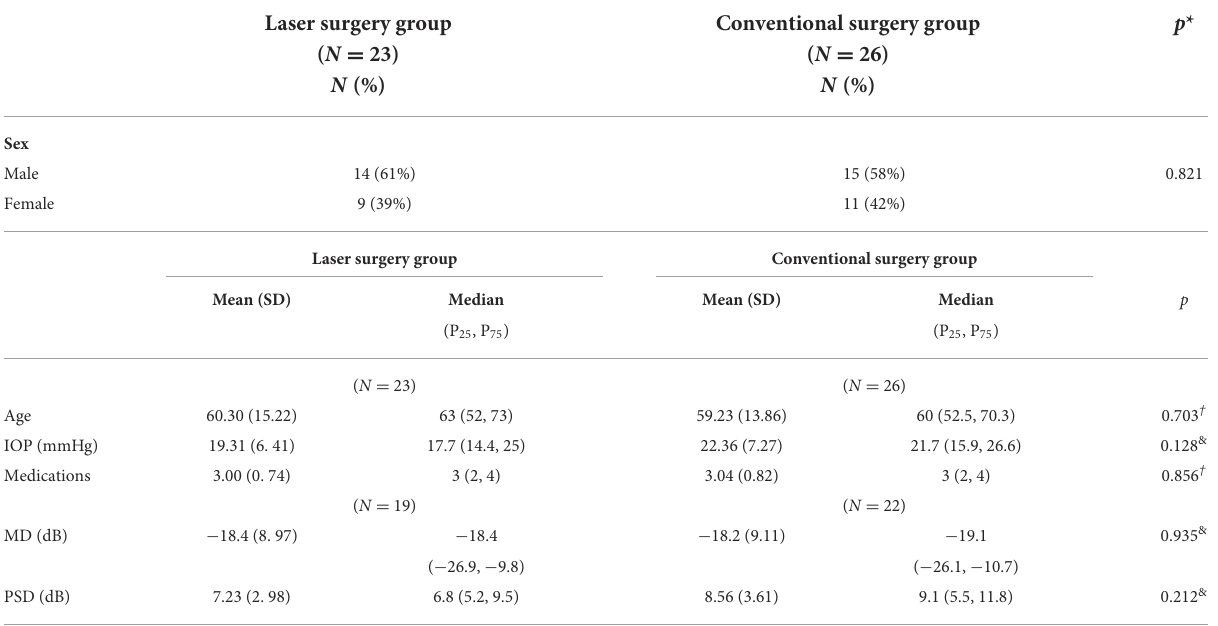
TABLE 1 Preoperative baseline information for both groups.